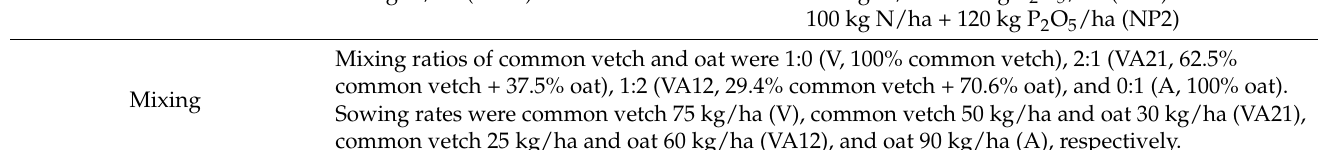
Table 2. Experimental design for fertilization and mixing treatments in 2019 and 2020. Treatment N Test in 2019